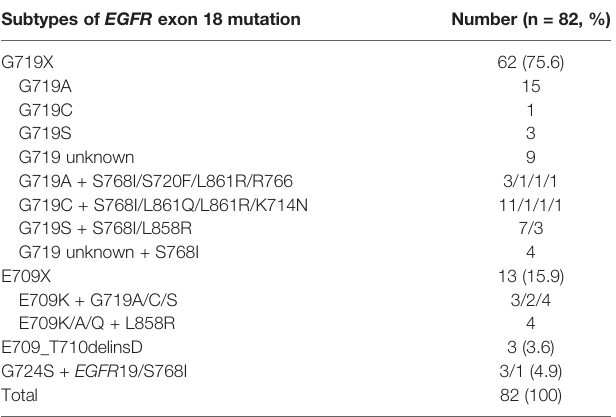
TABLE 2 | Different subtypes of EGFR exon 18 mutation found in this sample.